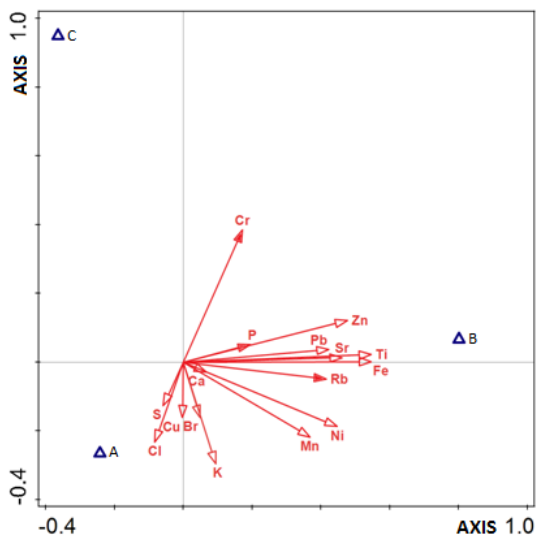
Figure 5: Discriminant analysis (CVA) of data on changes in the content of elements in the studied water biotopes: water reservoir stocked with fish (A), reservoir of technological water (B), and the drainage ditch of mining area (C). Elements, which significantly differentiate the test set indicates full returns vectors. It explain together 45.9 % of the total variability of